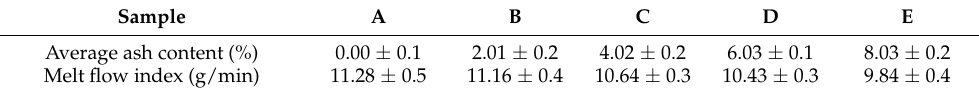
Table 3. Ash content and melt flow index of composites.